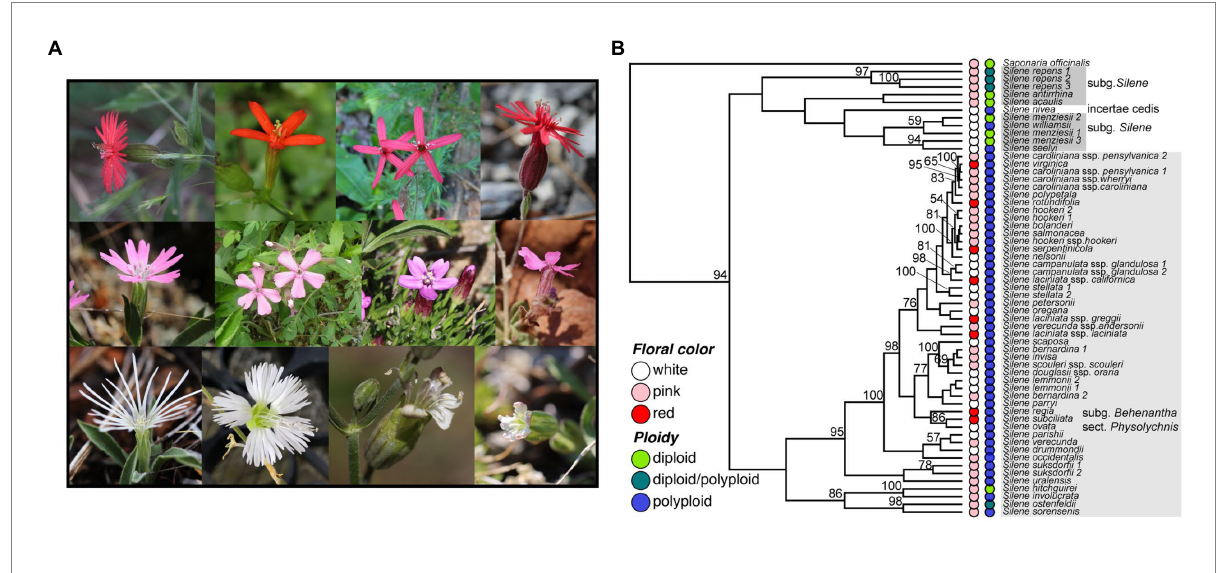
FIGURE 1 (A) Photos of four representative red-, pink-, and white-flowering native North American Silene species. Upper panel (red flowers), left to right: S. laciniata ssp. californica , S. subciliata , S. virginica , and S. serpentinicola . Middle panel (pink flowers), left to right: S. hookeri , S. caroliniana , S. acaulis , and S. petersonii . Lower panel (white flowers), left to right: S. nelsonii, S. stellata, S. sargentii, and S. parryi . (B) Maximum likelihood ITS gene tree with bootstrap support values demonstrating the distribution of floral color and ploidy in North American Silene sect. Physolychnis s.l. and other native North American Silene (sections boxed in gray) . Saponaria officinalis is included as an outgroup, and the tree is scaled using the divergence time between Saponaria and Silene . Floral color and ploidy are indicated in the colored circles adjacent to taxa. Bootstrap support values > 50 are shown to the left of nodes. Photo credits: S. laciniata, S. subciliata, S. virginica, S. serpentinicola, S. caroliniana, S. stellata by A. Berardi; S. hookeri, S. acaulis, S. petersonii, S. nelsonii, S. sargentii, S. and parryi by J.